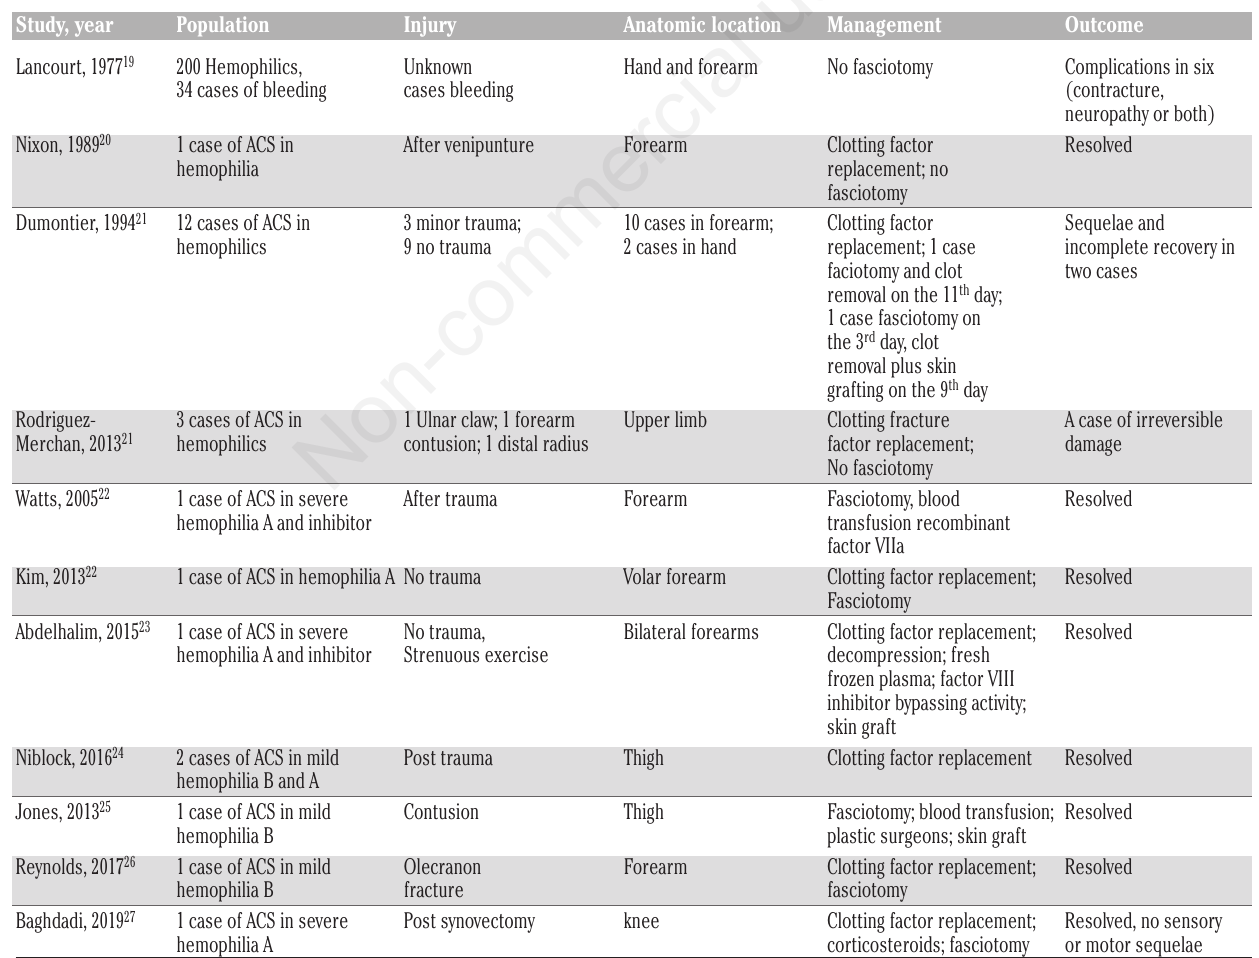
Table 1. Acute compartment syndrome in